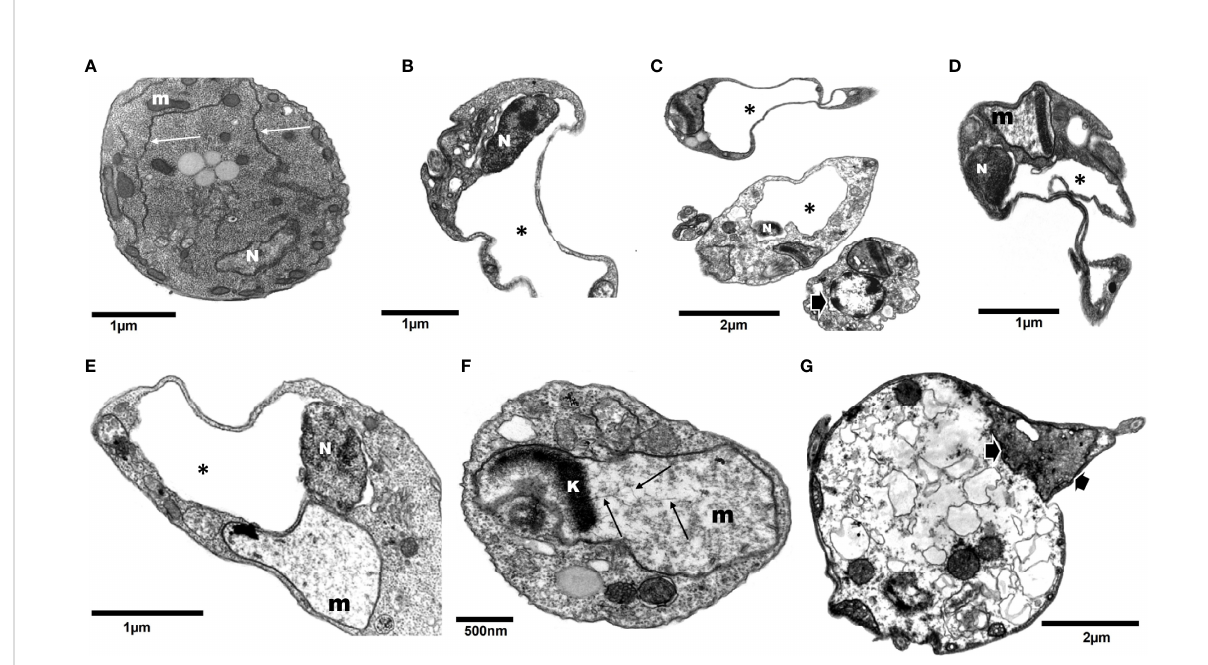
FIGURE 5 Transmission electron microscopy of T. cruzi epimastigotes (Y strain) incubated with 200 µM DETC for 24 h. Contrary to control cells ( A , arrows – endoplasmic reticulum cisternae; m- mitochondria; N- nuclei), DETC treated (B – G) displayed remarkably enlarged endoplasmic reticulum cisternae (B – E*) , often replacing an even distorting nuclei (B, C) . Some parasites displayed electroluscent nuclear matrix with aggregated peripheral dense chromatin ( C , arrow). Mitochondria were enlarged and generally presented reduced electrondensity (D – F) and eventually presenting kinetoplast (k) DNA (kDNA) disorganized fi bers ( F - arrows). Some cells displaying condensed mitochondria presenting swollen cristae ( C, G -arrows) were also observed. In the fi nal stage of treatment, parasites showed loss of normal compartmentation (G)